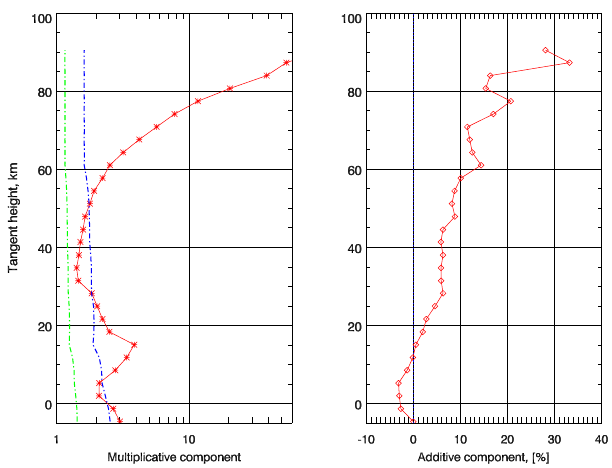
Figure 11. Fit results for the multiplicative and additive component as well as the simulated values for the same ground albedo as in Fig. 9. The colors are different. The blue line corresponds to the red line in Fig. 9 and the red line corresponds to the black line in Fig. 9. The green and the blue line are identical to the lines in Fig. 9. The red line is not due to the substraction of the additive component.